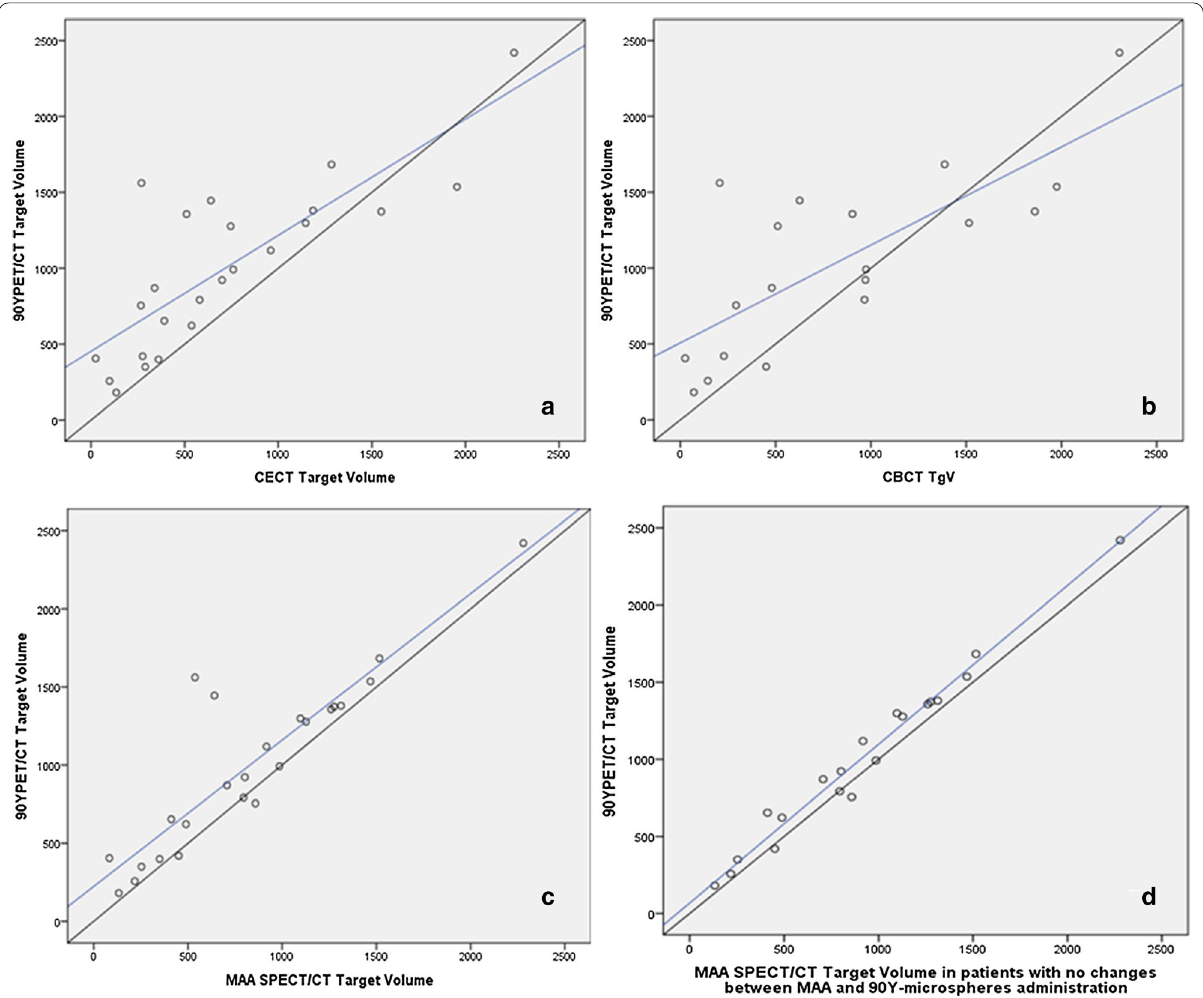
Fig. 2 Correlation (blue line) between the target volume obtained with 90 Y PET/CT and CECT ( a ), CBCT ( b ) and 99m Tc‑MAA SPECT/CT in all patients ( c ) and excluding patients with changes between MAA and 90 Y‑microspheres administrations ( d ). Diagonal black line indicates perfect correlation between both